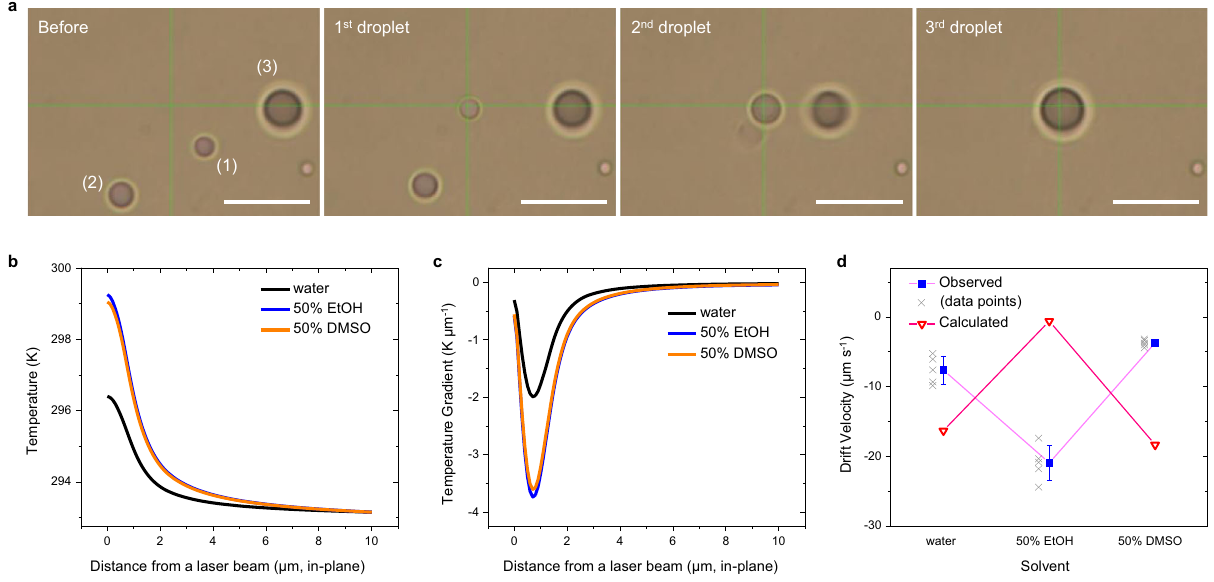
Fig. 2 Trapping of droplets in different solvent compositions. a Optical images of PFP droplets in 50% EtOH under OTTs, which show merging of three droplets. Parenthesized numbers indicate the order of trapping. b Simulated in-plane temperature and c temperature gradient pro fi les from a laser beam in different solvent compositions: water (black), 50% EtOH (blue), and 50% DMSO (green). The negative sign of temperature gradient indicates the direction pointing toward the laser beam. d Observed (blue) and calculated (red) drift velocity of PFP droplets in different solvent compositions (mean ± standard deviation, n = 5). Gray symbols represent individual data points. Calculated values are obtained at fi xed τ using Eq. (1) to assess the contribution of other available parameters (i.e., bulk solvent terms, temperature gradient, and zeta potential) to the drift velocity. The negative sign of the velocity indicates that the direction is the same as that of the temperature gradient. Source data are provided as a Source data fi Table 1 Physical parameters of solvents at 20 °C, calculated thermophoretic mobility and drift velocity at a constant τ of 2, and relative τ derived from the observed drift velocity.